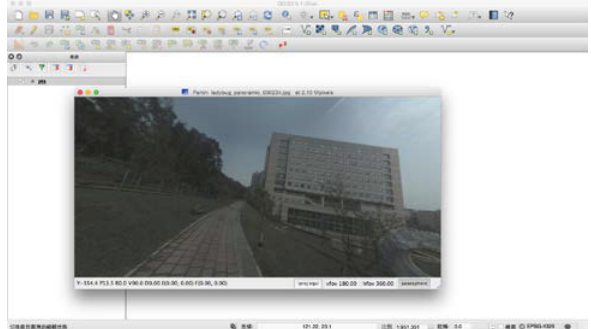
Figure 4. Panorama Viewer Panini in